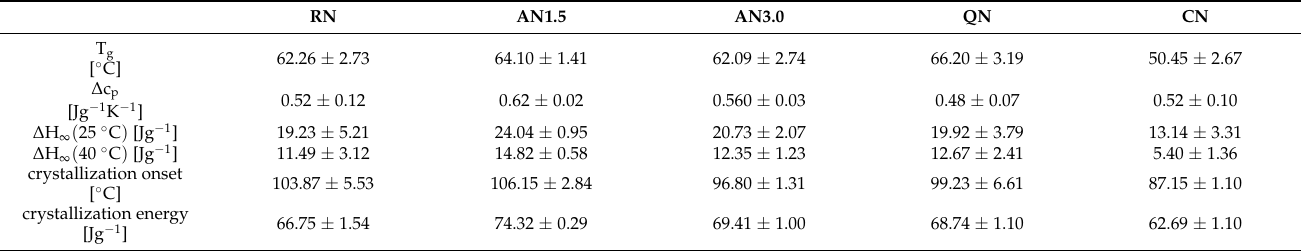
Table A2. Calorimetric data of the 2gl_0.4PS_Suc [ ◦ C]. n = 2, values represent the mean value and the corresponding standard